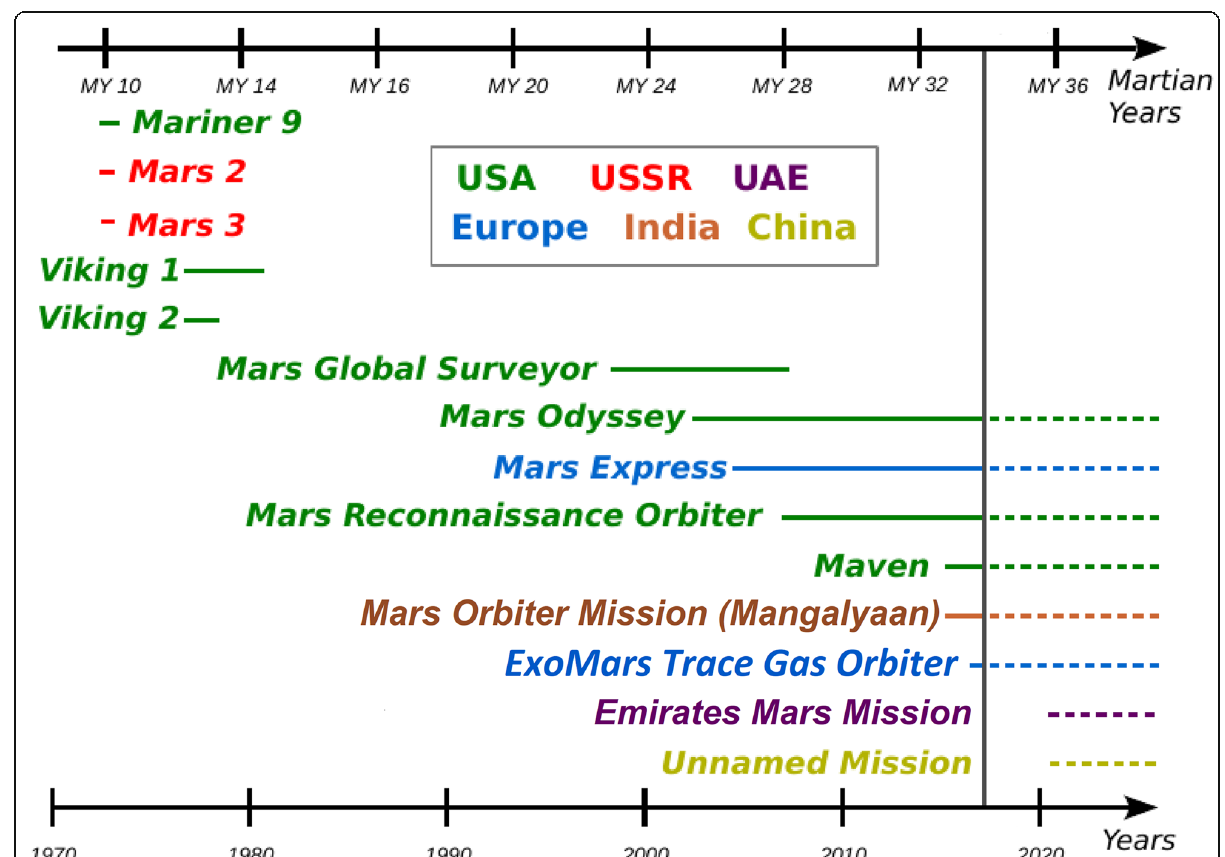
Fig. 1 Timelines of satellite Mars missions successfully completed to date (Mariner 9, Mars 2, Mars 3, Viking 1, Viking 2, Mars Global Surveyor); currently in science operation (Mars Odyssey, Mars Express, Mars Reconnaissance Orbiter, Mars Atmosphere and Volatile Evolution (MAVEN), Mars Orbiter Mission (Mangalyaan), ExoMars Trace Gas Orbiter); and upcoming in the near future (Emirates Mars Mission and others). The color coding specifies the countries of origin. The time axis denotes both Martian (top) and Earth (bottom) years. Adapted from Navarro et al.